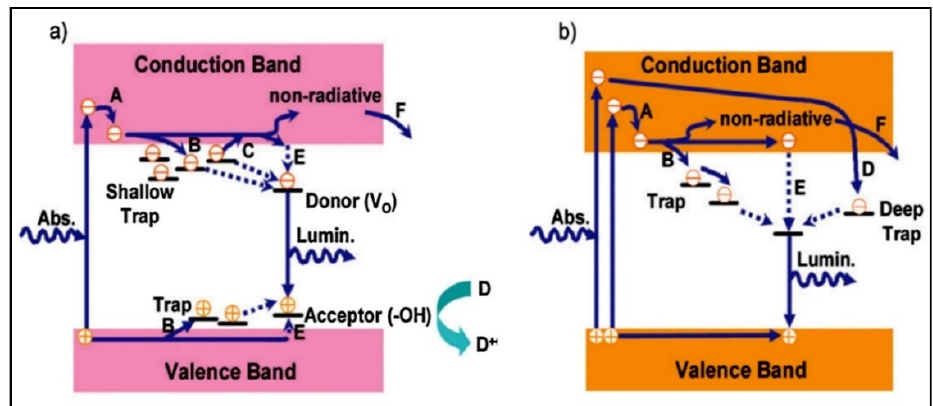
Figure 7. Tapping and recombination of photogenerated charge carriers in anatase ( a ) and rutile ( b ), reprinted with permission from reference [175]. Copyright 2019 Elsevier B.V.